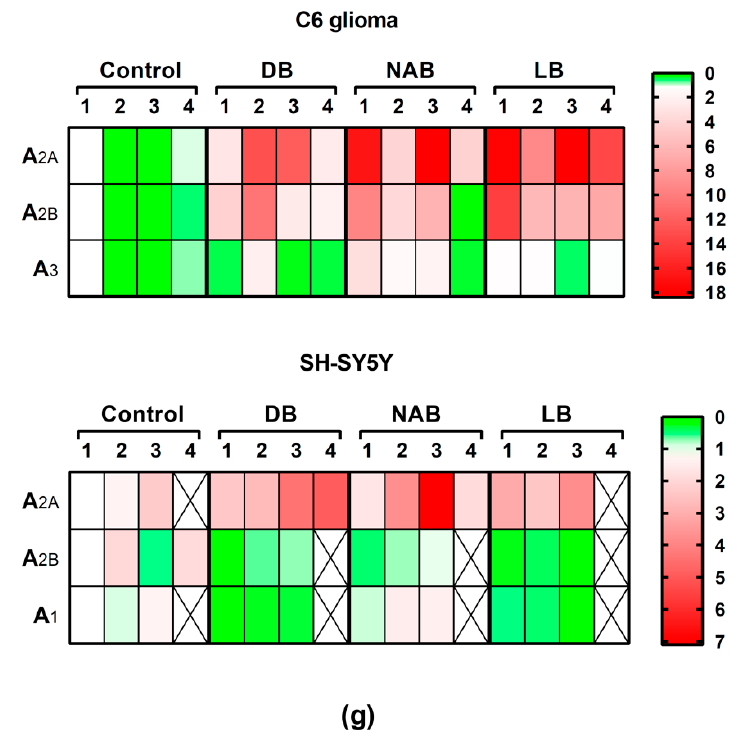
Figure 2. Adenosine receptors gene expression assayed by quantitative real-time RT-PCR in C6 and SH-SY5Y cells. After total RNA isolation, A 2A (panels a and b), A 2B (panels c and d), A 3 (panel e), and A 1 (panel f) receptor gene expression levels were detected by using TaqMan universal PCR following the protocol indicated in “Materials and Methods”. β -actin was used as an endogenous control in all assays. The treatments were performed for 24 h with DB, NAB, and LB extracts in C6 ( a , c , e ) and SH-SY5Y ( b , d , f ) cells. ( g ) Heatmap of gene expression levels obtained from the analyzed samples. Data are means ± SEM of, at least, three independent assays; * p < 0.05, ** p < 0.01, and *** p < 0.001, significantly different from their corresponding control (C) according to Student’s t test; # p < 0.05, and ## p < 0.01, significantly different from control (C) or considered bars according to one-way ANOVA test.